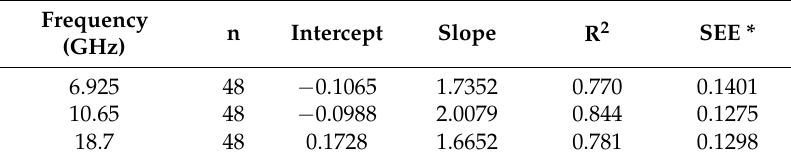
Table 2. Analysis of covariance (ANCOVA) to test whether slopes resulting from linear fit of PH NDVI and PH VOD differed significantly by microwave frequency. With Bonferroni adjustment, the p CRIT is 0.0167 (=0.05/3).